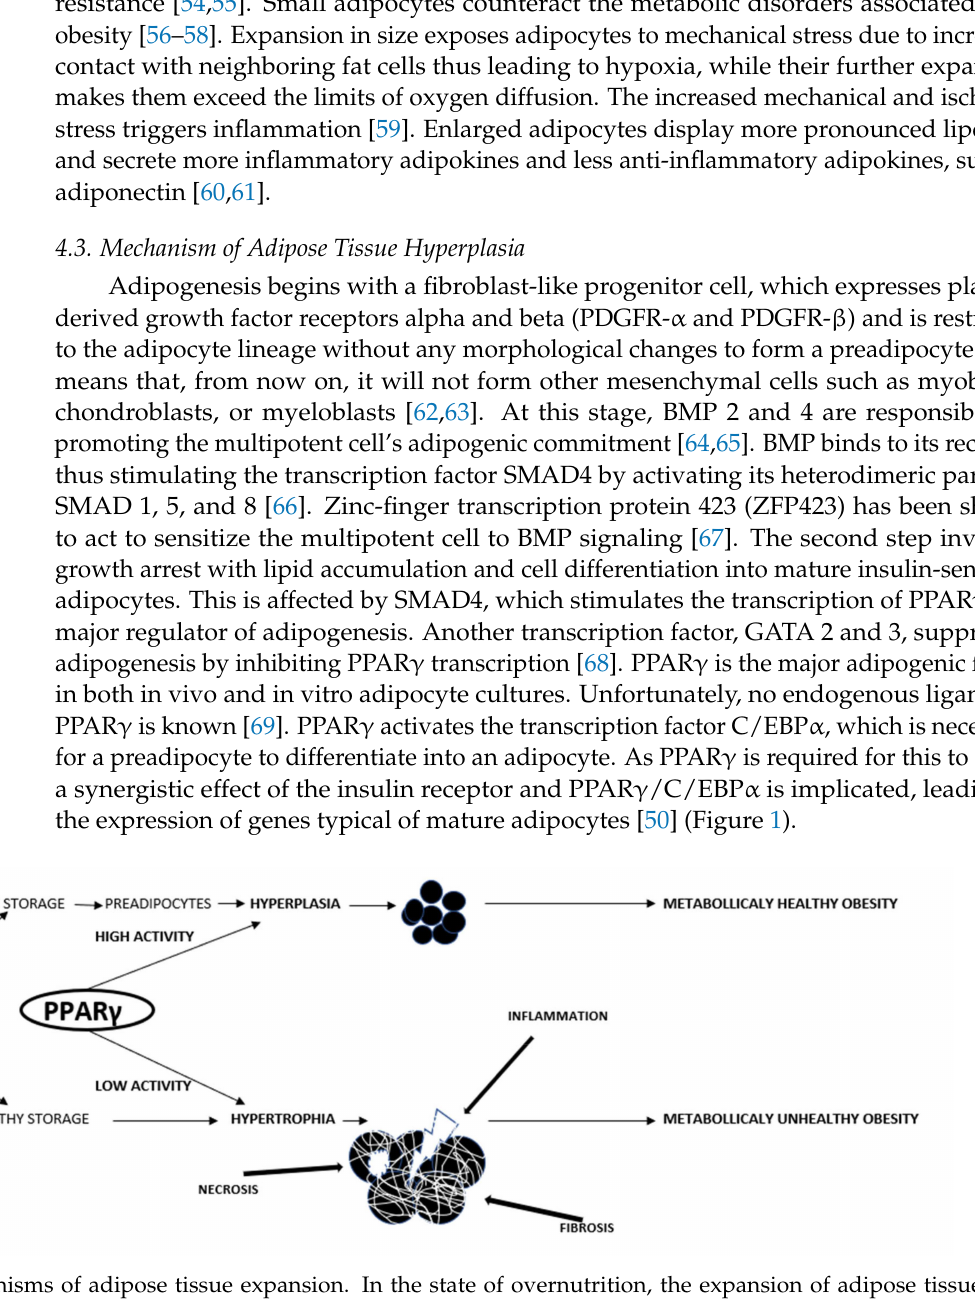
Figure 1. The mechanisms of adipose tissue expansion. In the state of overnutrition, the expansion of adipose tissue can be driven either by increasing the sizes of the existing adipocytes (hypertrophy) or by forming new ones (hyperpla- sia/adipogenesis). Adipogenesis is achieved by differentiating mesenchymal cells into preadipocytes and then adipocytes. Adipogenesis begins with fibroblast-like progenitor cells (kind of mesenchymal cells) and is restricted to the adipocyte lineage without any morphological changes to form a preadipocyte. This means that from now on it will not form other mesenchymal cells such as myoblasts, chondroblasts, or myeloblasts. At this stage, BMP 2 and 4 are responsible for promot- ing the multipotent cell’s adipogenic commitment. The second step involves growth arrest with lipid accumulation and cell differentiation into mature insulin-sensitive adipocytes. This is affected by SMAD4, which stimulates the transcription of PPAR γ , the major regulator of adipogenesis. Expansion in size exposes adipocytes to mechanical stress due to increased contact with neighboring fat cells, thus leading to hypoxia, while their further expansion makes them exceed the limits of oxygen diffusion. The increased mechanical and ischemic stress triggers inflammation and